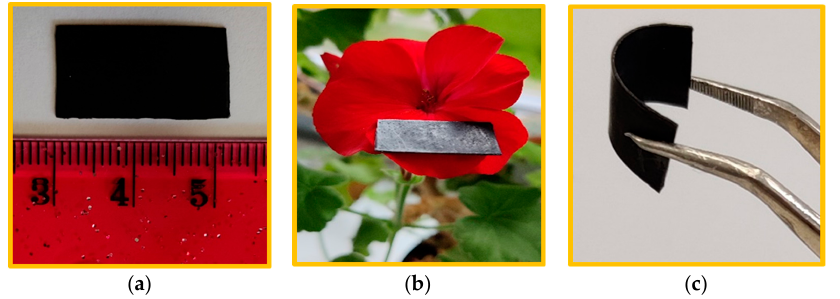
Figure 13. ( a – c ) Digital photograph for the demonstration of dimension, lightweight, and flexibility of prepared CuF3 and rGO based TPU